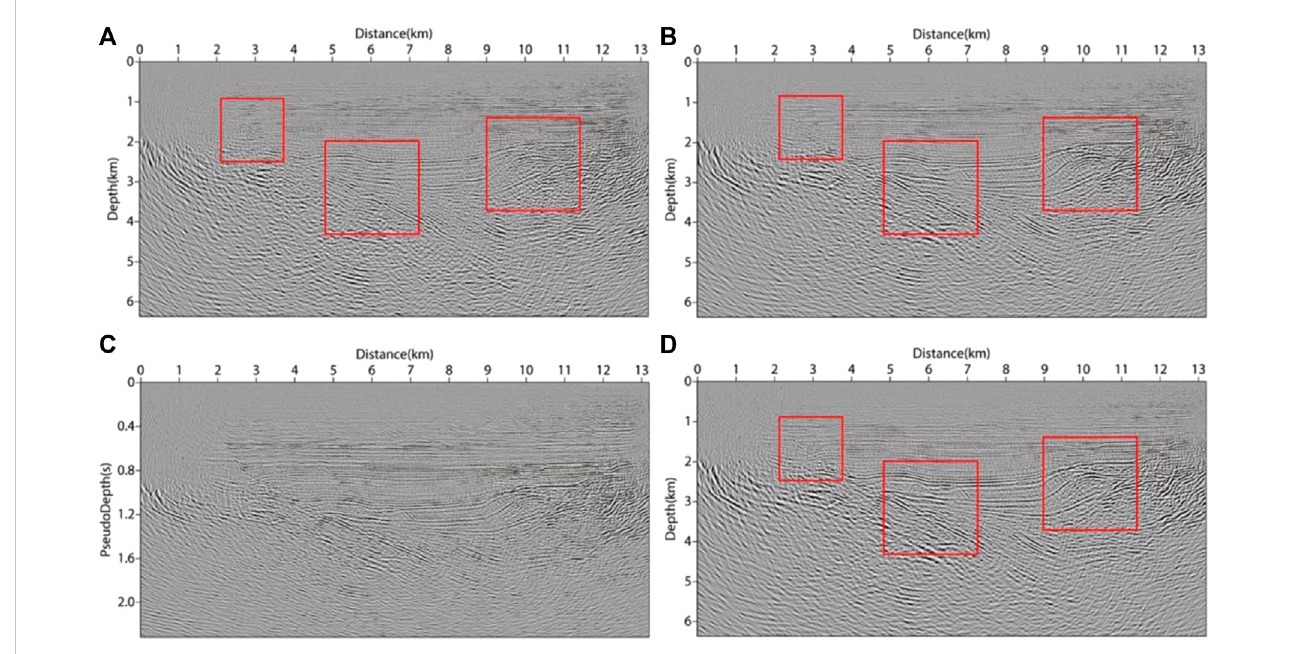
FIGURE 17 Migration results ofthe land fi eld data set. (A) acoustic isotropy RTM method; (B) VTI-RTM method in depth domain; (C) VTI-PDRTM methodin pseudo- depth domain; (D) VTI-PDRTM method transformed back to the depth